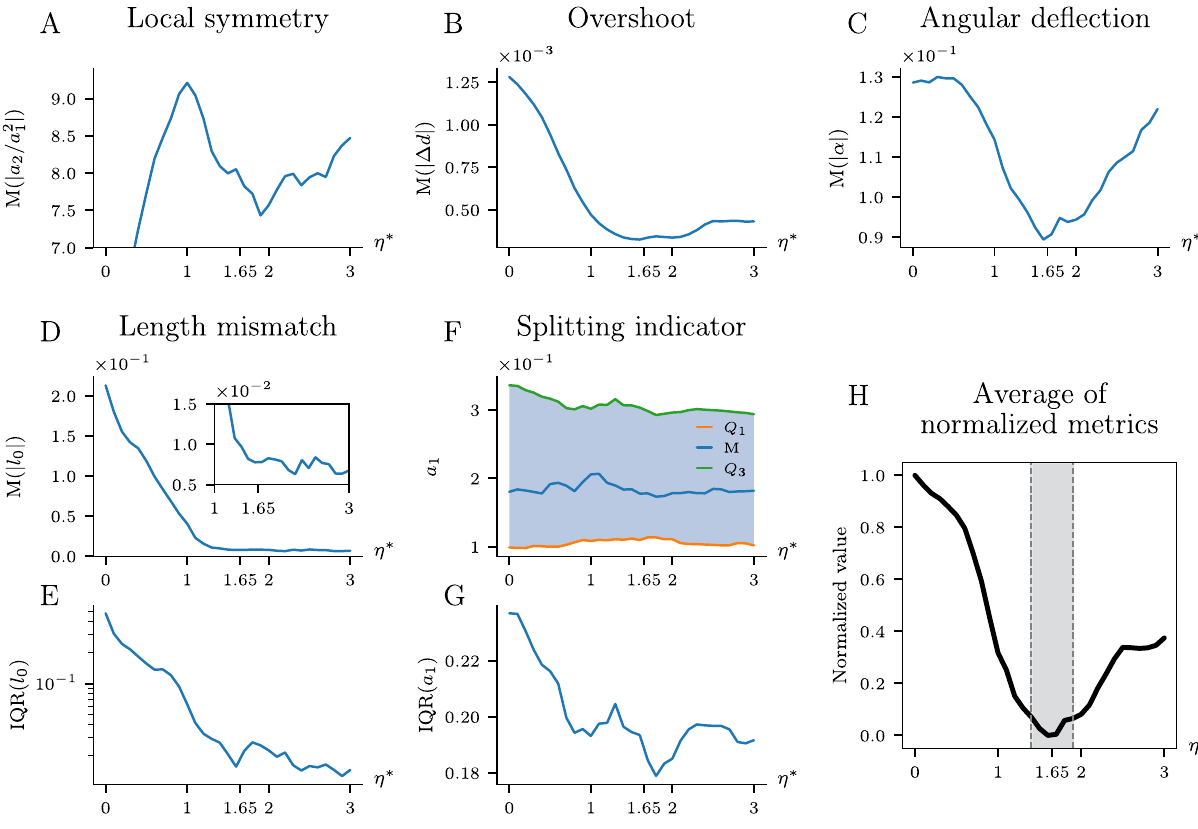
Figure 8. Results of the BEA on the White River network in Vermont, USA. ( A – C ) Median of the absolute value of the local symmetry, overshoot, angular deflection ( D – E ) Length mismatch (median of the absolute value and IQR) ( F – G ) Splitting indicator (quartiles and IQR) ( H ) Average of normalized metrics with a minimum around η ∗ = 1.65 ± 0.25 (marked on each